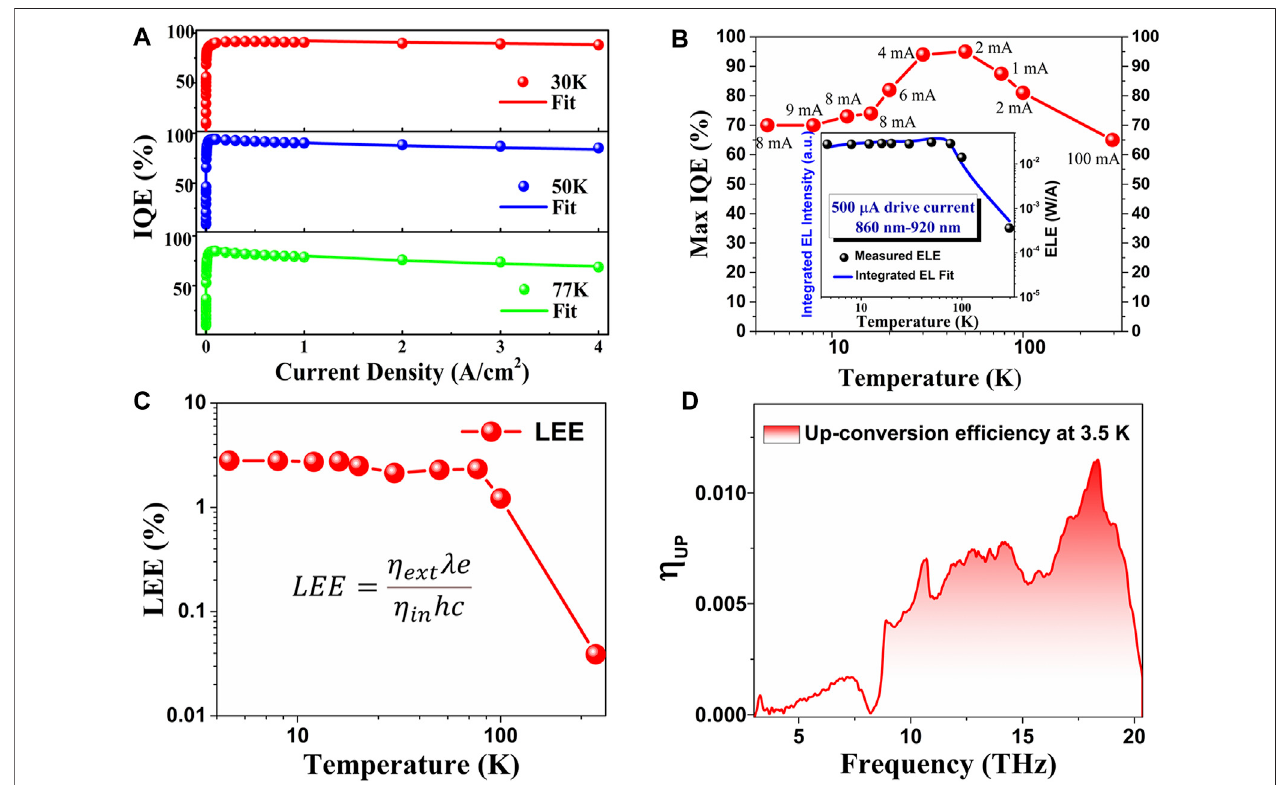
FIGURE 3 | (A) Injection current density-dependent internal ef fi ciencies and the fi t results of the LED at 30, 50, and 77 K, respectively. (B) η max and corresponding J max at different temperatures, and the inset is the measured external ef fi ciency of the LED at different temperatures with the same injection current (0.5 mA). (C) The calculated light extraction ef fi ciency ( LEE ) at different temperatures. (D) Calculated upconversion ef fi ciency with a bias voltage of 1.8 V.